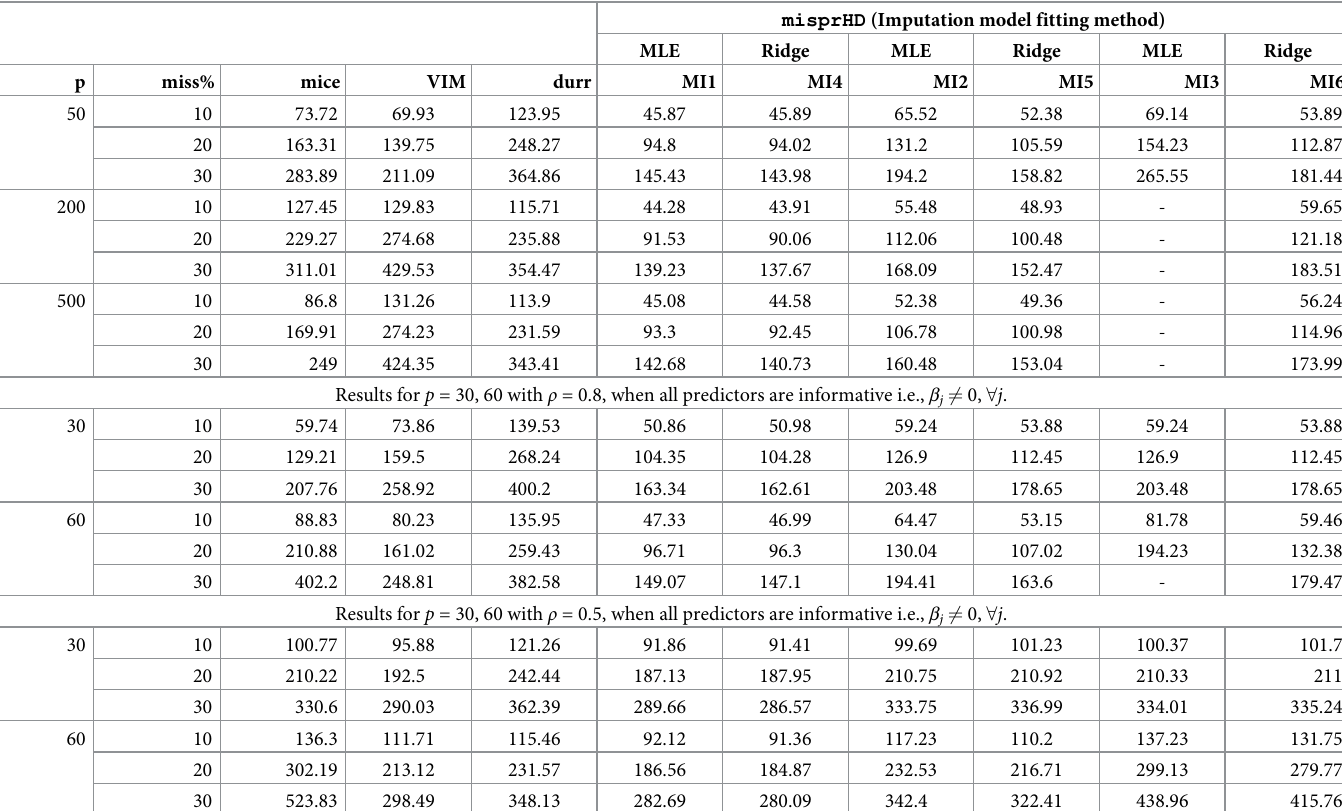
Table 1. Simulation study: Mean Squared Imputation Error (MSIE).